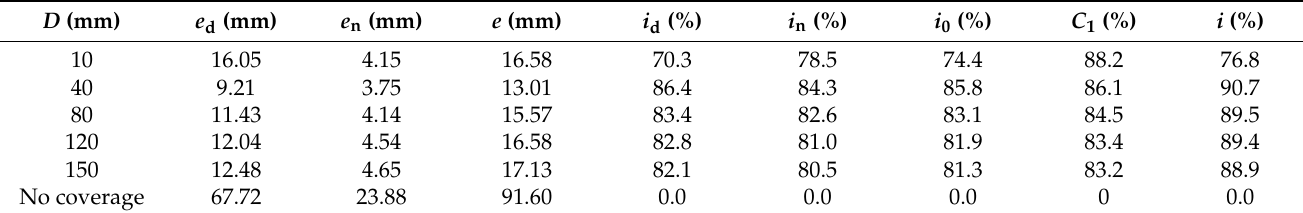
Table 4. Calculation of evaporation inhibition rate in still water.